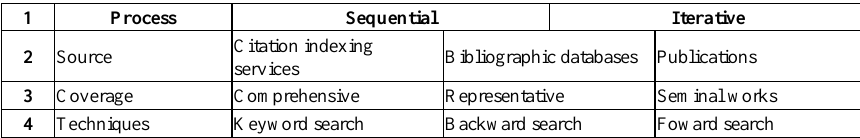
Table 1. Definition of the search scope of the paper [based on 9,